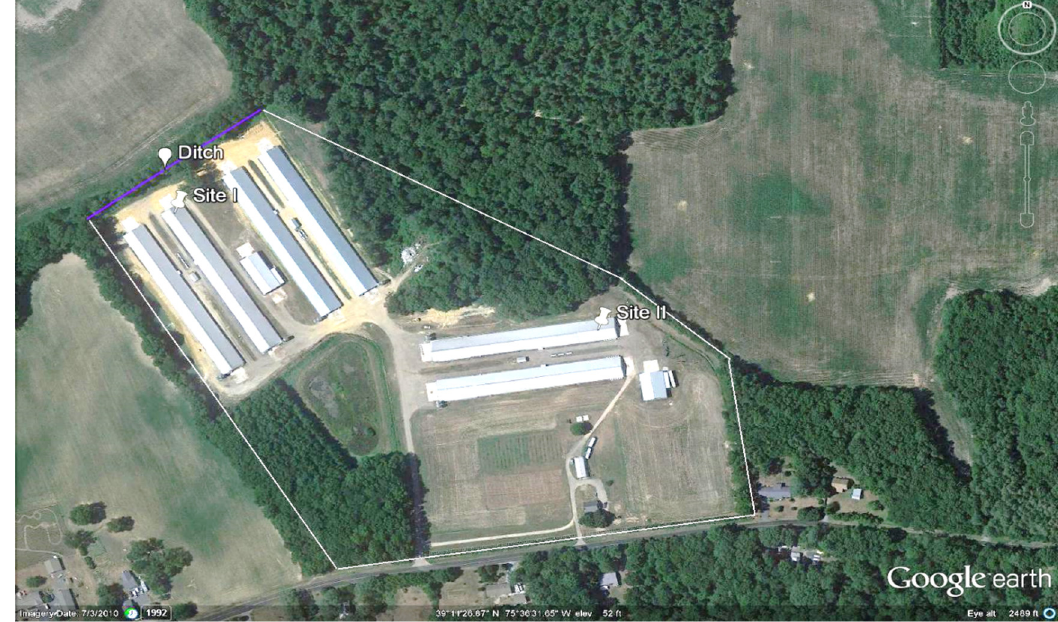
Figure 1. Aerial view of the poultry farm equipped with heavy use area protection pads. Please see Table 1 for the specific sites descriptions.